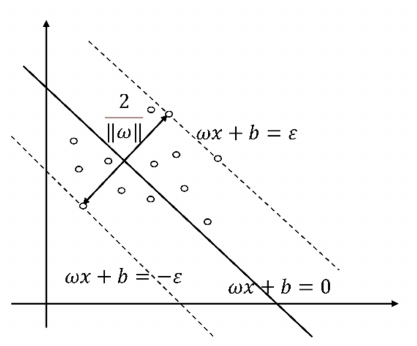
Figure 1. A schematic diagram of support vector regression